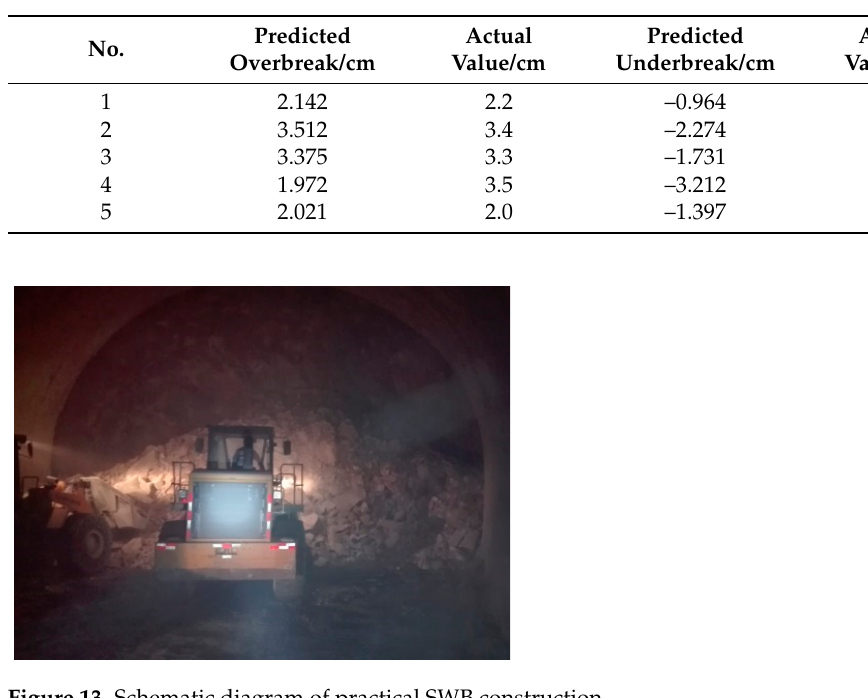
Figure 13. Schematic diagram of practical SWB construction.